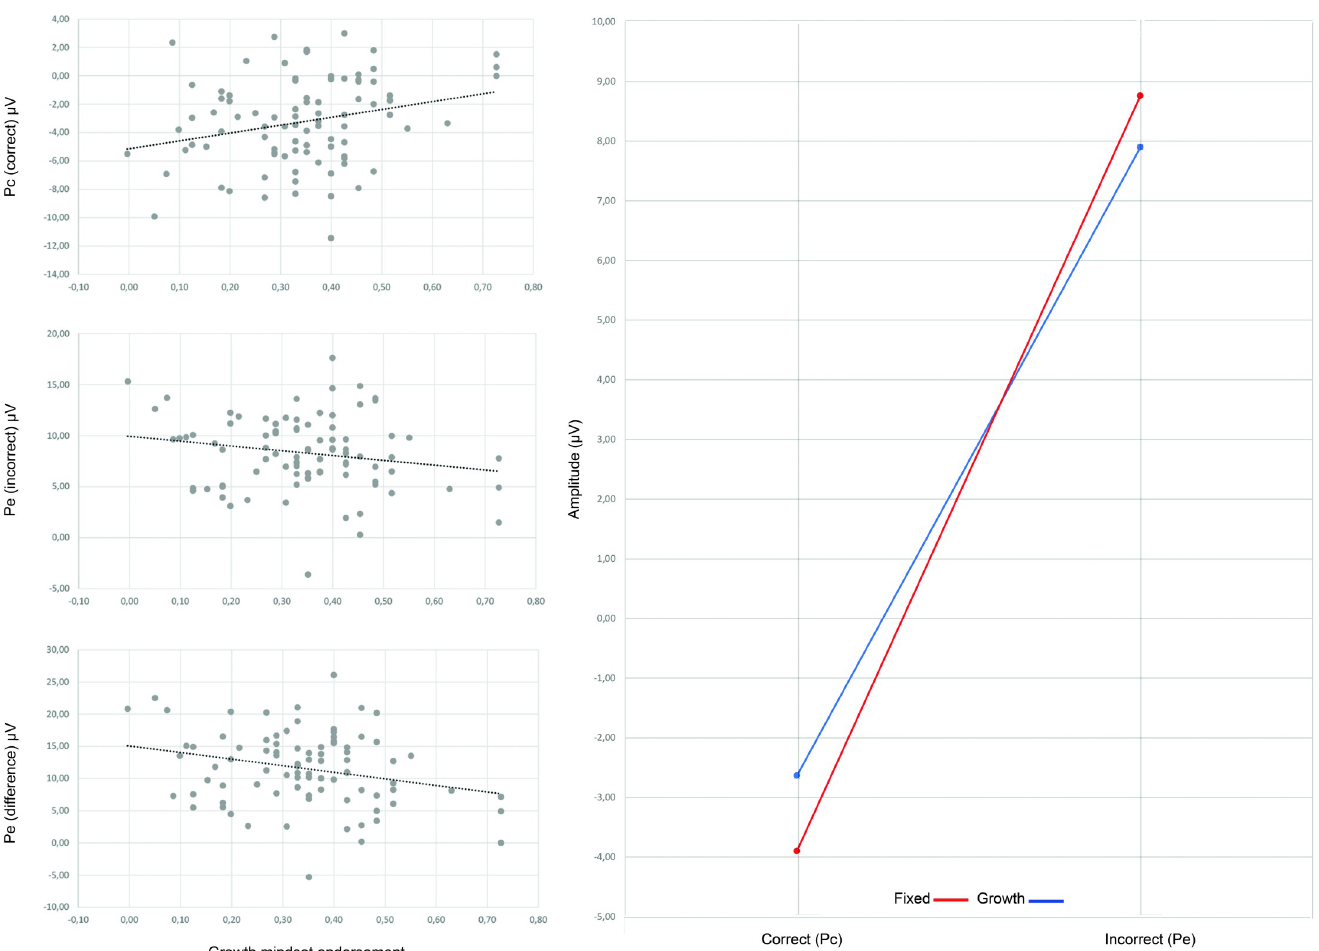
Fig 4. Scatter plots of Pc/Pe/difference amplitude at Pz against growth mindset endorsement. Note . The x-axis shows the log-transformed mindset scale, with more positive numbers reflecting stronger growth mindset, while lower numbers reflecting stronger fixed mindset endorsement. Dotted line is the regression line. Correct = correct response, Incorrect = incorrect response (stop error). Pc = positive correct ERP, Pe = error positivity ERP, Pe difference = Pe–Pc.